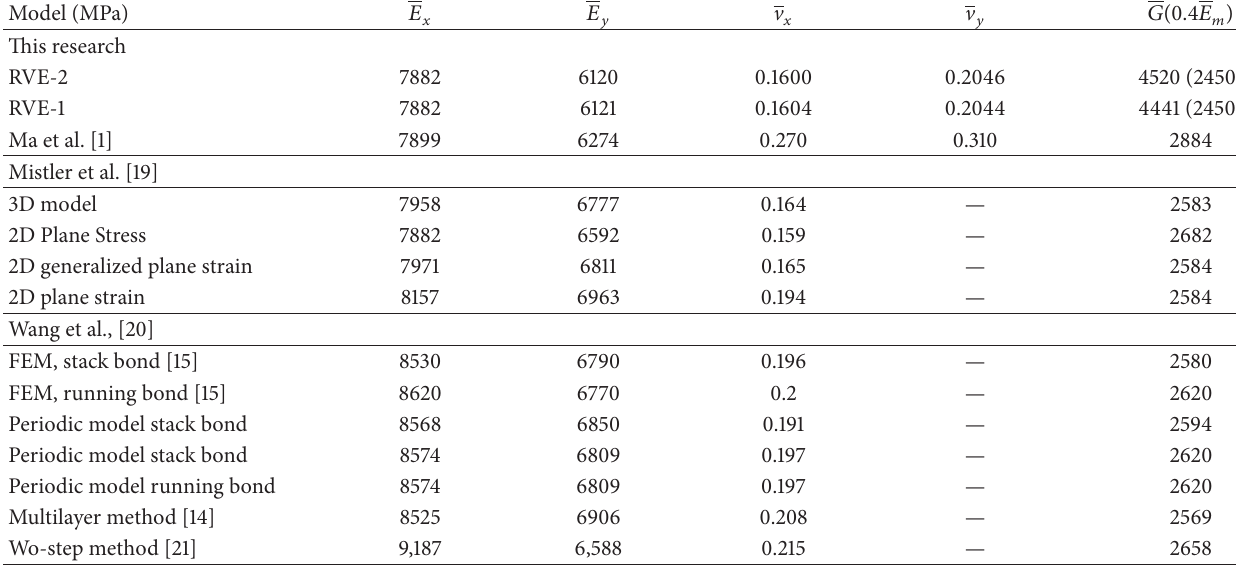
Table 3: Homogenization model result from various researcher.